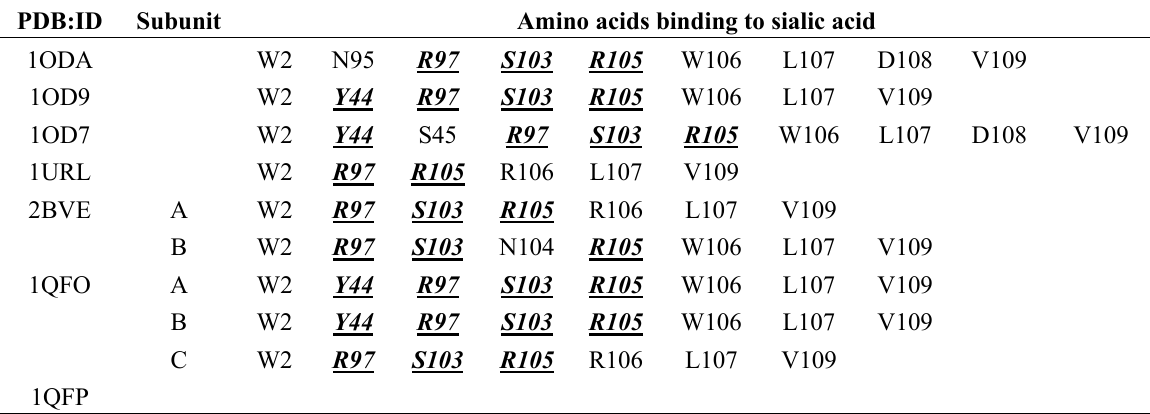
Table 2. Interactions of mSN amino acids with sialic